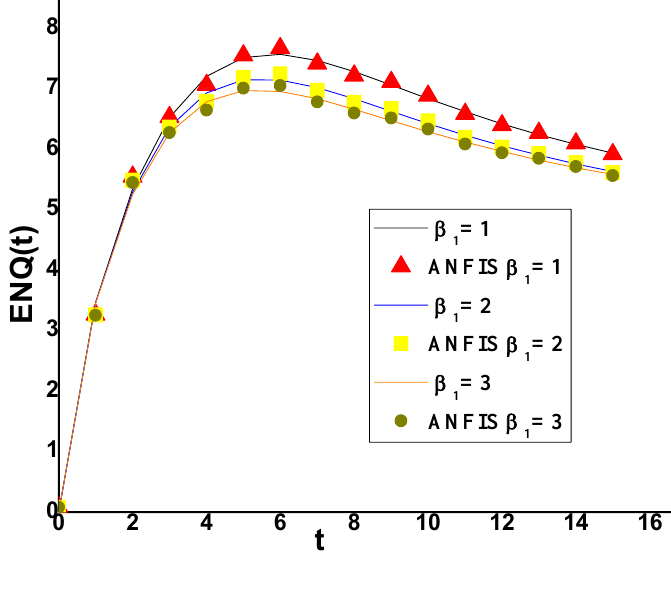
Figure 2. ENQ(t) at various values of